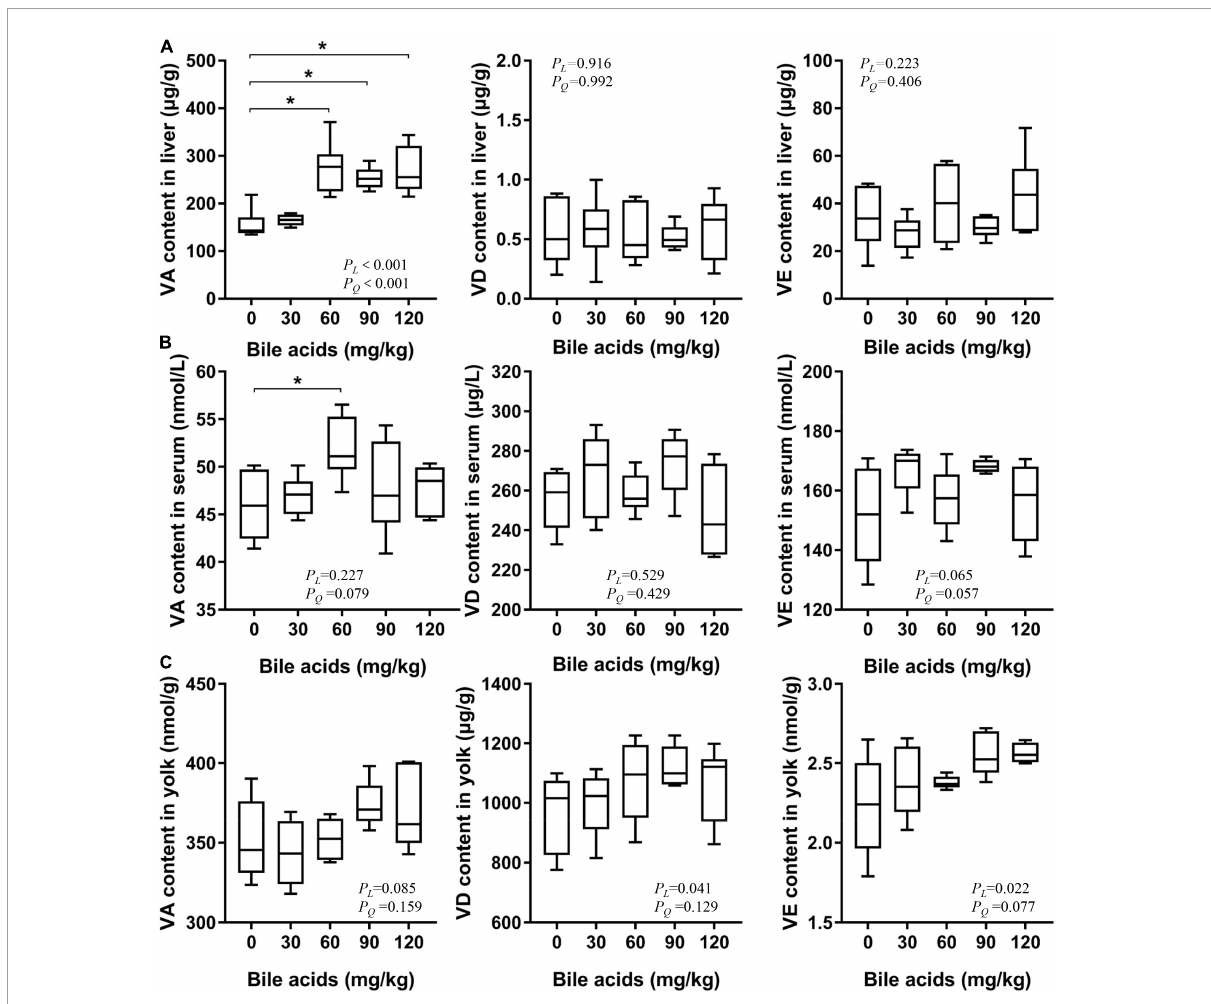
FIGURE3 Porcine bile acids enhanced vitamin A absorption in laying hens. VA, vitamin A. VD, vitamin D. VE, vitamin E. P L , linear P -value. P Q , quadratic P -value. (A) Porcine bile acids improved vitamin A content in the liver of laying hens. (B) Porcine bile acids improved vitamin A content in serum of laying hens. (C) Porcine bile acids did not affect fat-soluble vitamins content in egg yolks. (A–C) Each box represents the mean value of six hens each treatment ( n = 6). Whiskers represent maximum and minimum. Different at P < 0.05 is marked as